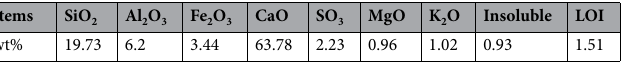
Table 1. Cement chemical composition.